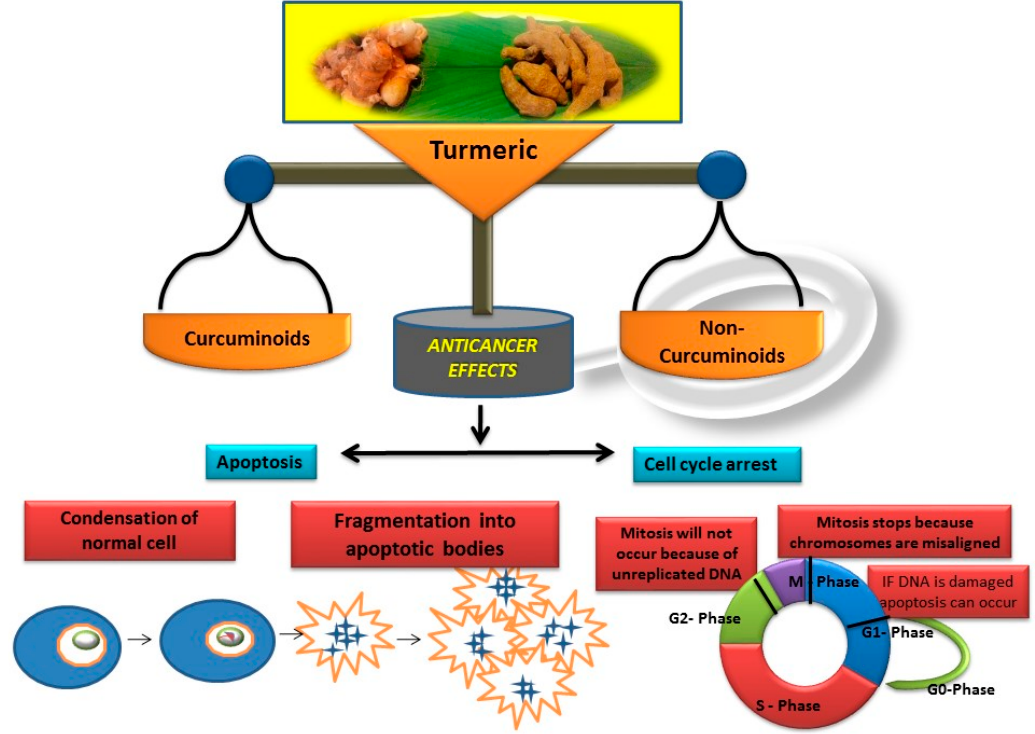
Figure 1. Schematic representation of anticancer activities of non-curcuminoids. Abbreviations: DNA, deoxyribonucleic acid.